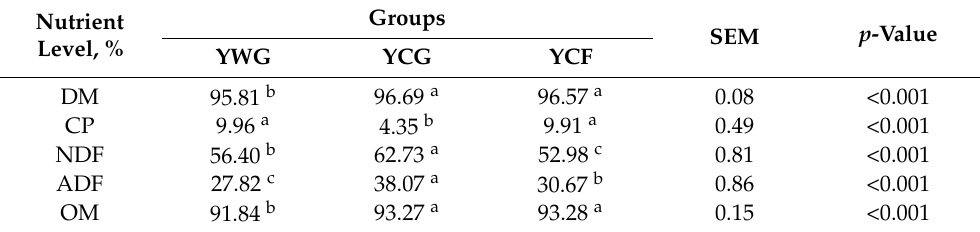
Table 2. Nutrient level and feed intake of experimental groups dietary (dry matter basis, %). Nutrient Groups